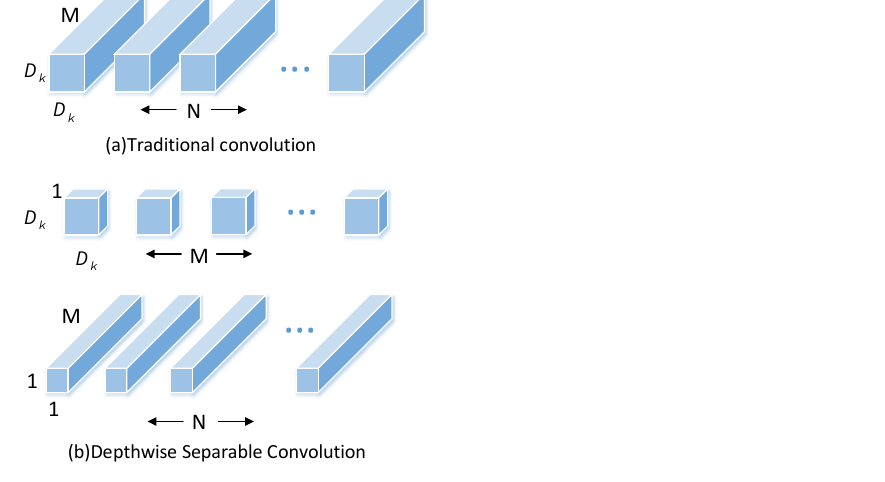
Figure 3. The difference between traditional convolution and depthwise separable convolution.